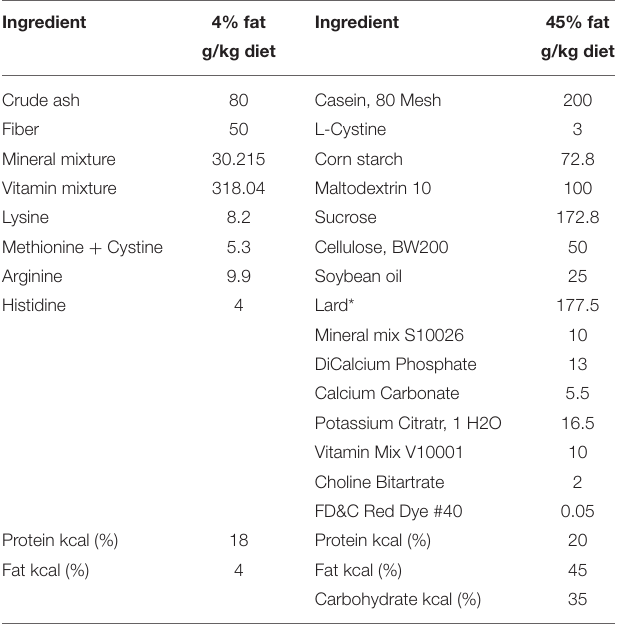
TABLE 1 | Ingredient composition of the diets fed to rats